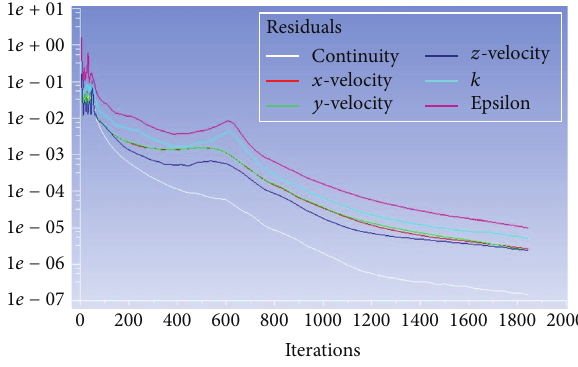
Figure 4: Convergence plots of the CFD